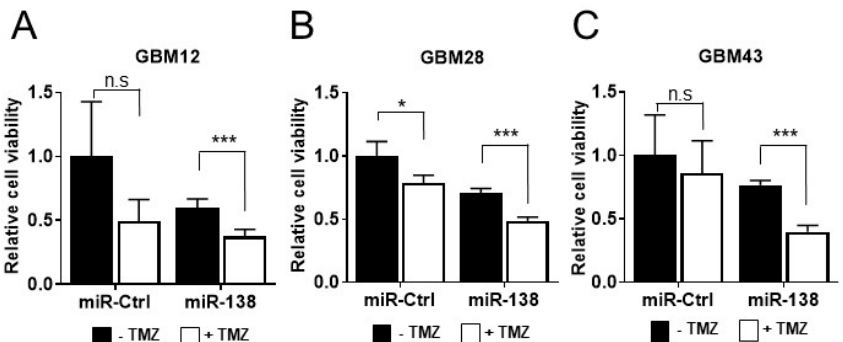
Figure 1. Combination of TMZ with miR-138 over-expression increases inhibition of cell prolifer- ation in vitro. Patient-derived primary GBM cells, ( A ) GBM12, ( B ) GBM28 and ( C ) GBM43, were transfected with miR-138 mimics or negative control (miR-Ctrl). After 4 days of transfection, viable cells were measured by CellTiter-Glo Luminescent Cell Viability Assay. All error bars indicates standard deviations ( n = 3), and the p -values were determined by two-tailed student t -test. * p < 0.05, *** p < 0.001, n.s = not significant.